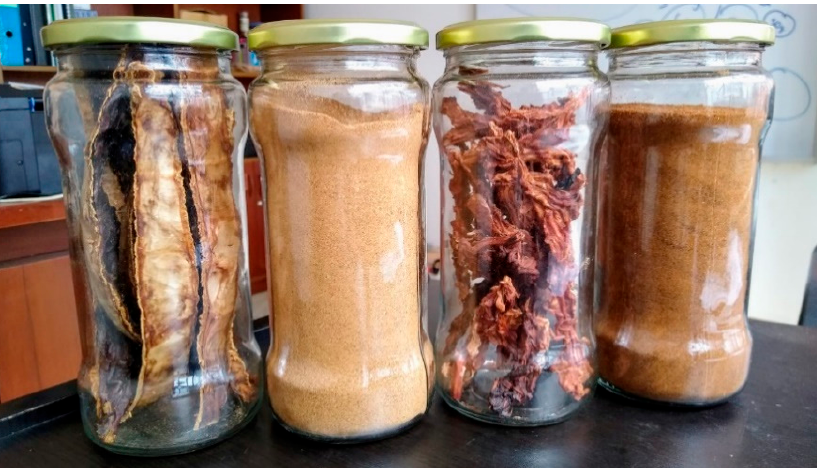
Figure 1. Pod husk and its flour ( left ) and vein and its flour ( right ).